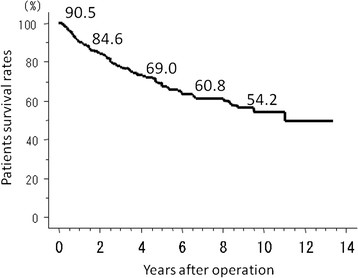
Survivals of all 521 patients at 1, 2, 5, 7, and 10 years were 90.5%, 84.6%, 69.0%, 60.8%, and 54.2%, respectively.